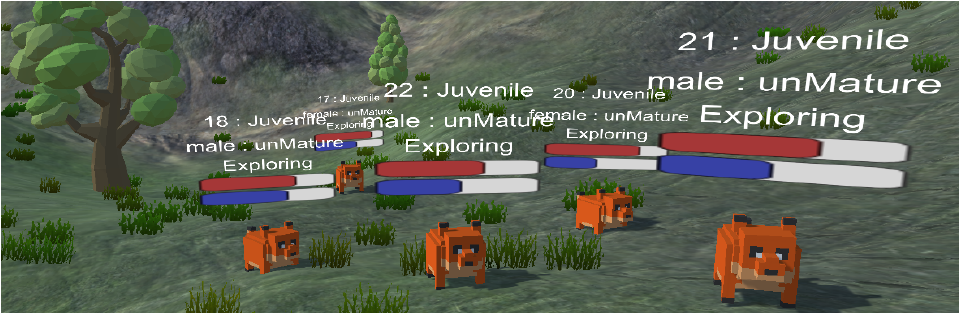
Figure 5. Constant exploration is necessary to fulfill the daily requirements, such as thirst and hunger.